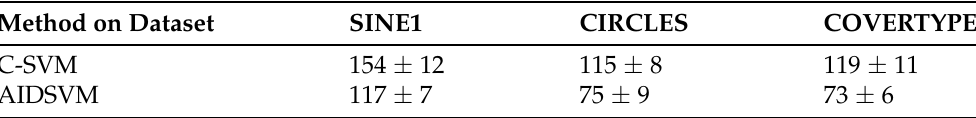
Table 3. Running time comparison between C-SVM and AIDSVM, in milliseconds per training sample. Training was carried out on 5000 samples with a window size of 1000, for all datasets.